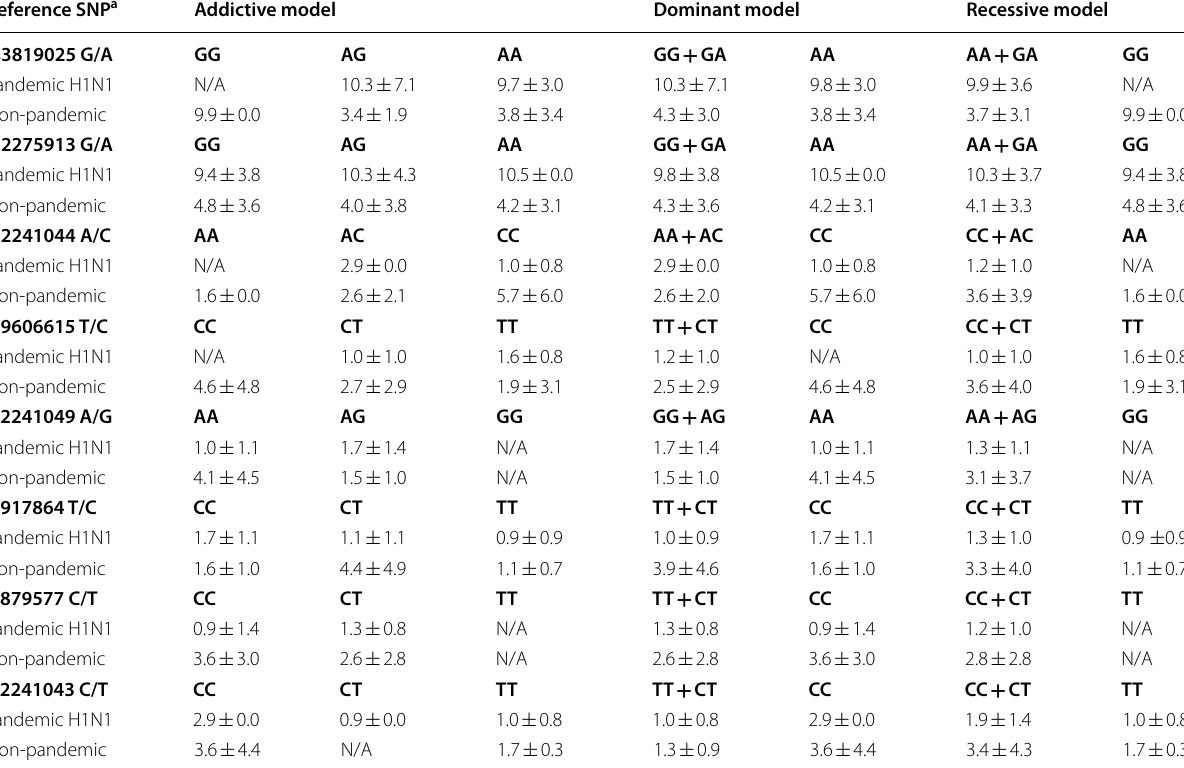
Table 3 Correlation between tissue expression and genotyping distribution in IL17A and IL17RA for three